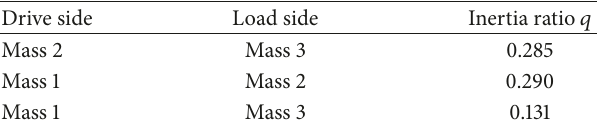
Table 3: The combination of